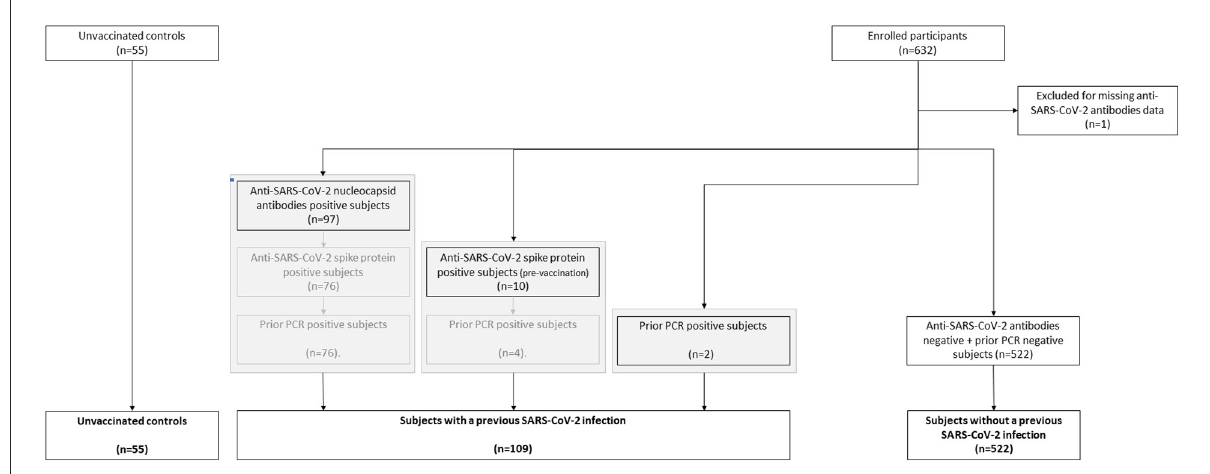
FIGURE1 Flow chart of the classification of subjects vaccinated with ChAdOx1-S with and without prior COVID-19.